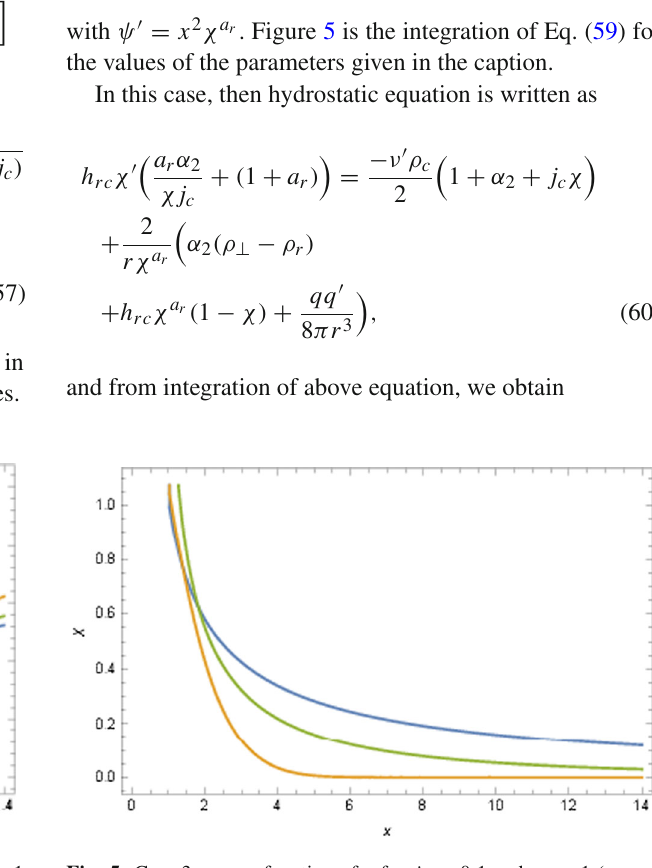
Fig. 5 Case 3. χ as a function of x for j c = 0 . 1 and a r = 1 (orange line), a r = 2 (green line), a r = 3 (blue